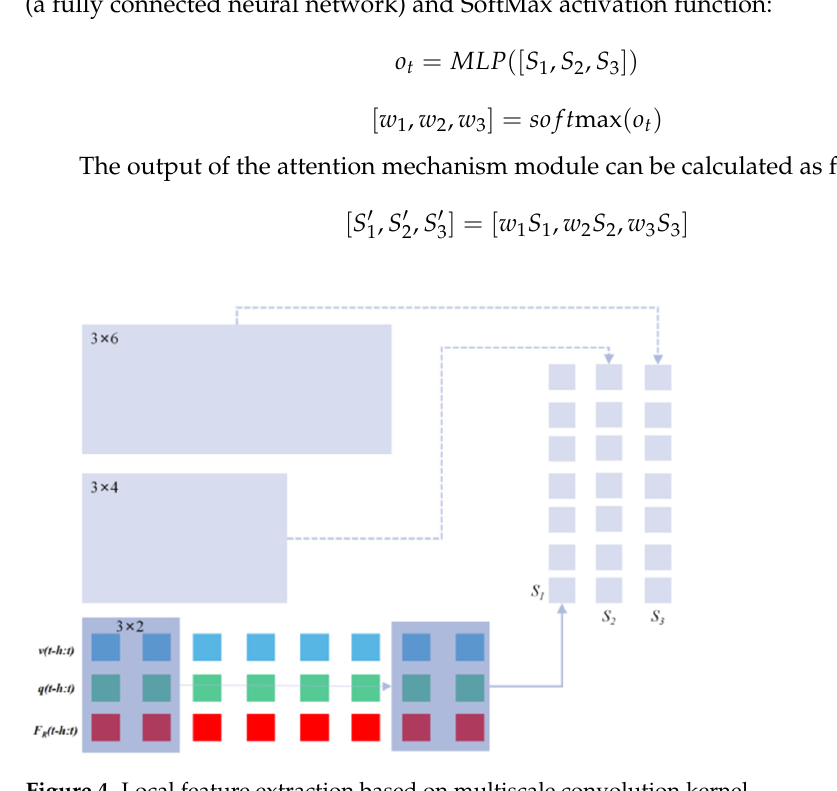
Figure 4. Local feature extraction based on multiscale convolution kernel.